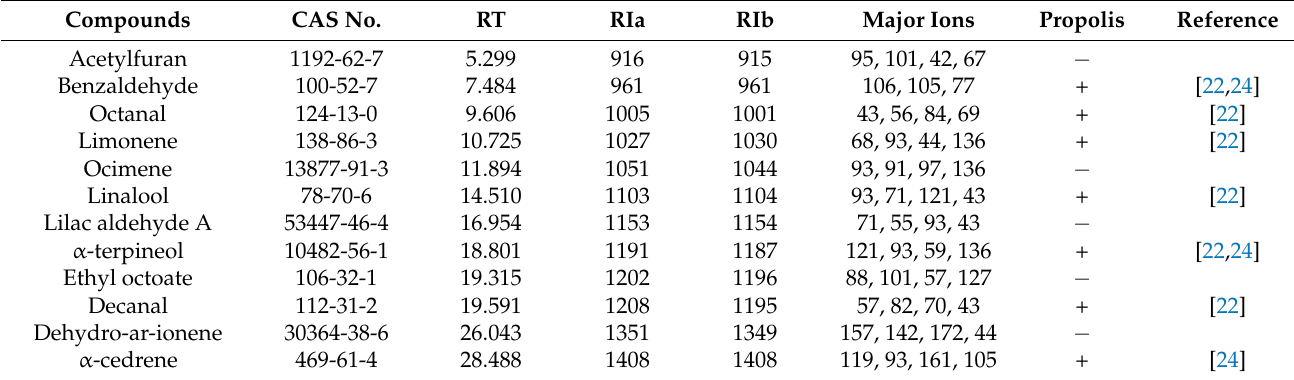
Table 2. Potential markers in AMC identified by GC −